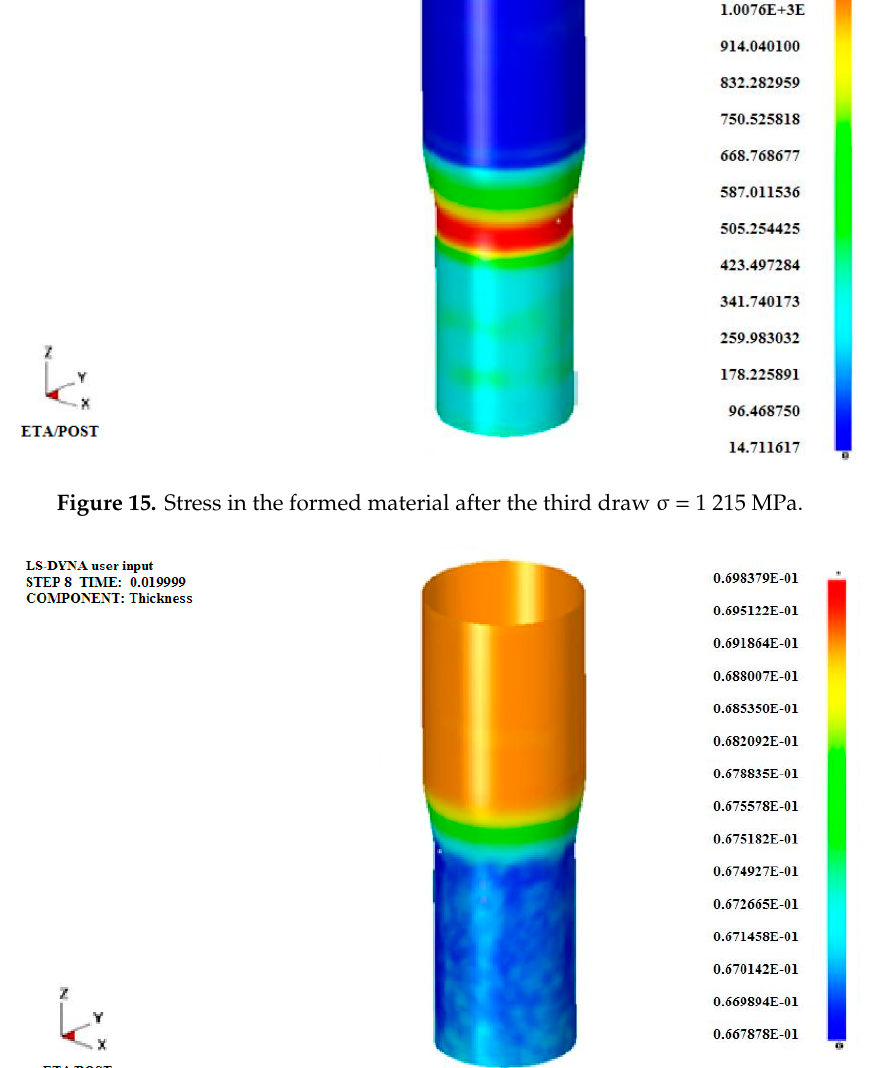
Figure 16. Wall thickness after the third draw s n = 0.0667 mm.